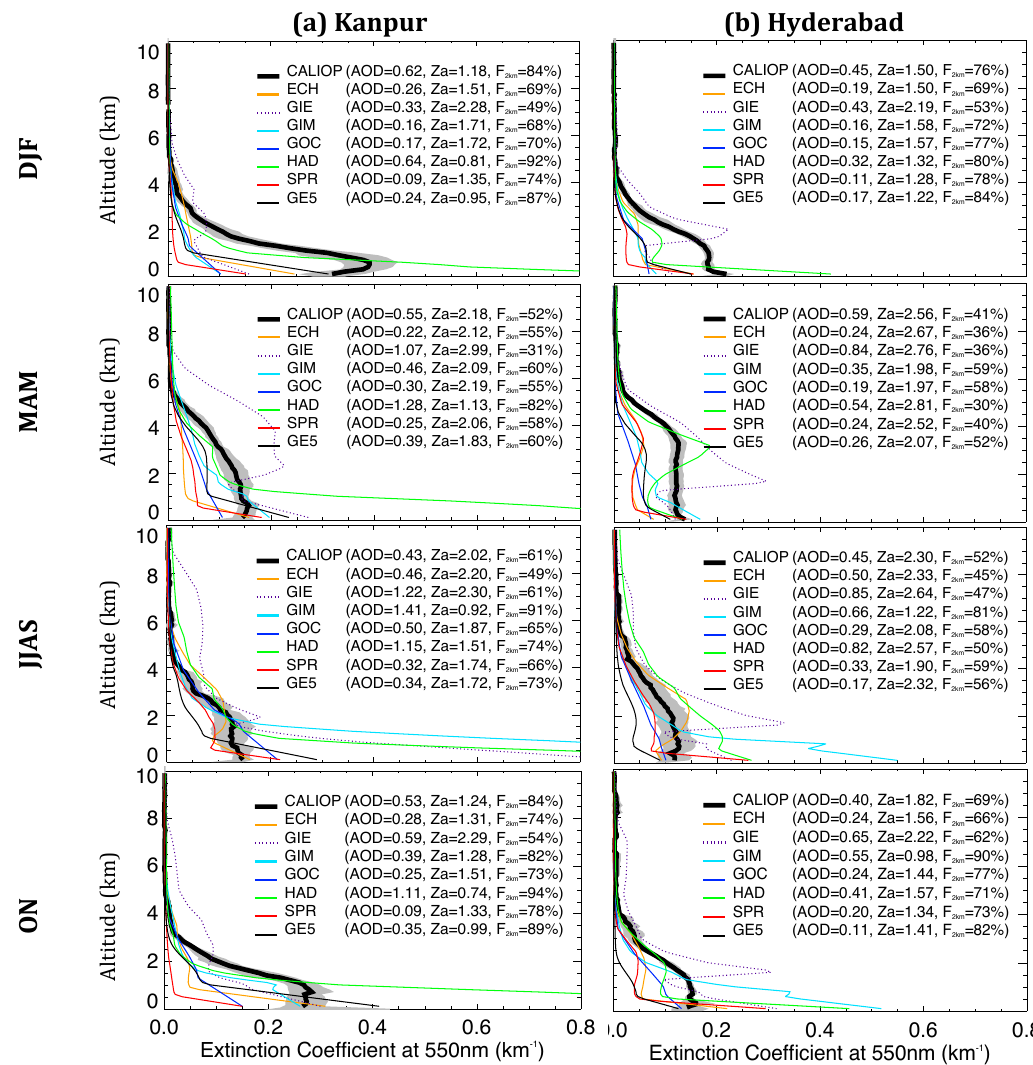
Figure 8. Seasonal mean of vertical profile of extinction coefficient (units: km − 1 ) at (a) Kanpur, and (b) Hyderabad from CALIOP and seven models. The corresponding seasonal mean AOD, Za (units: km) and F 2km are listed after each symbol name. The gray shaded area in CALIOP is 1 standard deviation relative to the average of